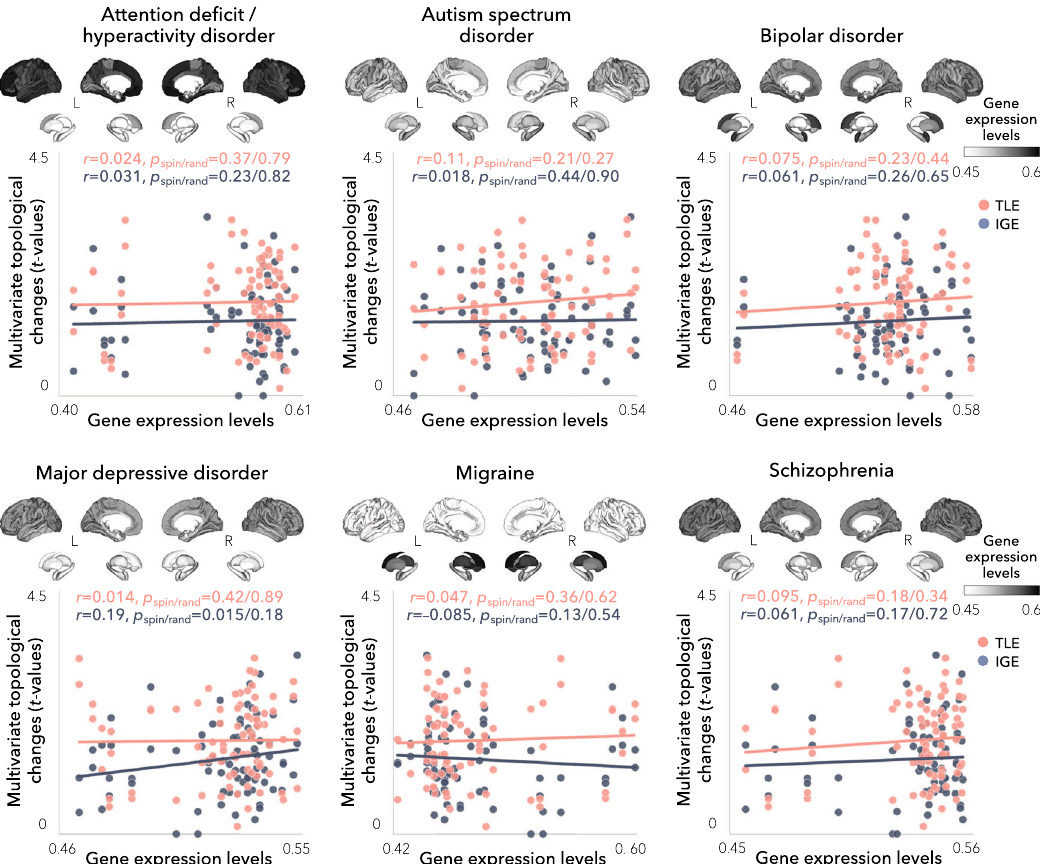
Fig. 5 Relations between disease-related gene expression and network topology. Gene expression levels associated with six common neuropsychiatric conditions and/or comorbidities of epilepsy (attention de fi cit/hyperactivity disorder, autism spectrum disorder, bipolar disorder, major depressive disorder, migraine, and schizophrenia) were mapped to cortical and subcortical surface templates. Spatial correlations were performed between each of these transcriptomic maps and the patterns of multivariate topological alterations in TLE and IGE across cortical and subcortical regions ( n = 82) and were statistically assessed using one-tailed, non-parametric tests. In IGE, a spatial association between microarray data and multivariate topological changes was signi fi cant for expression levels of major depression disorder genes ( r = 0.19, p spin = 0.015). This association, however, did not survive correction against a null distribution of effects based on selecting random genes ( p rand = 0.18). In TLE, network associations did not correlate with any other disease-related transcriptomic maps. HC = healthy control, IGE = idiopathic generalized epilepsy, TLE = temporal lobe epilepsy, p spin = p -value corrected against a null distribution of effects using a spatial permutation model, p rand = p -value corrected against a null distribution of effects using a “ random-gene ” permutation